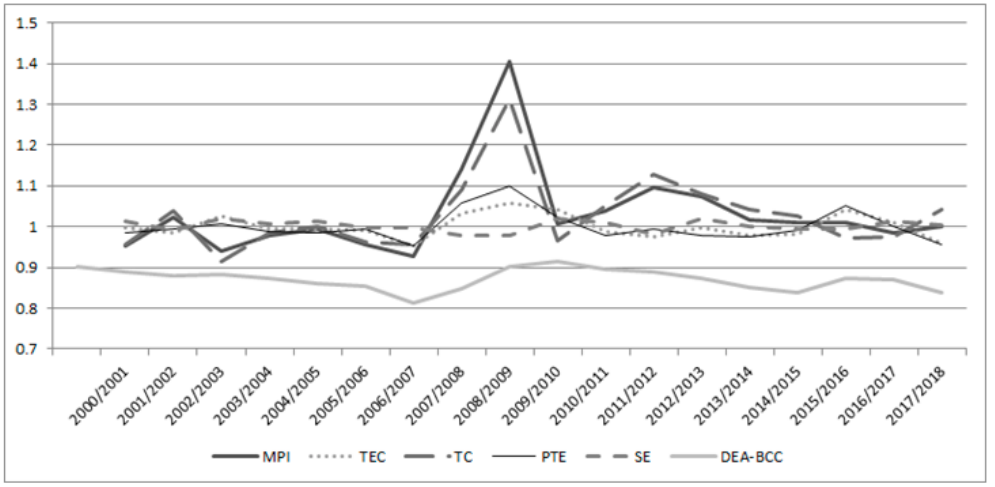
Figure 2. Development of average environmentally sensitive efficiency and productivity changes.